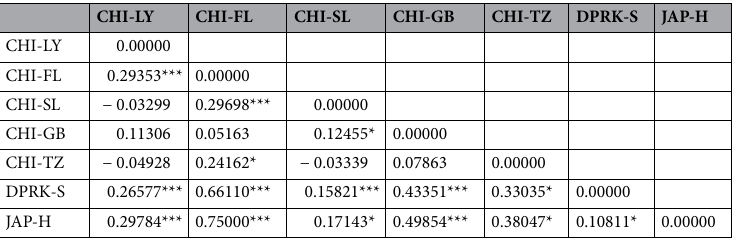
Table 2. Results of F-statistics analysis of seven regions for COI. *P < 0.05; **P < 0.01; ***P < 0.001.